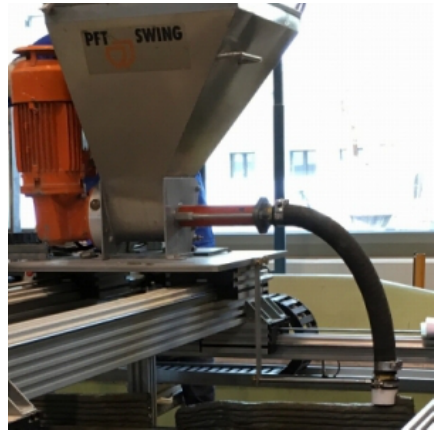
Figure 2. 3D-concrete-printing test device